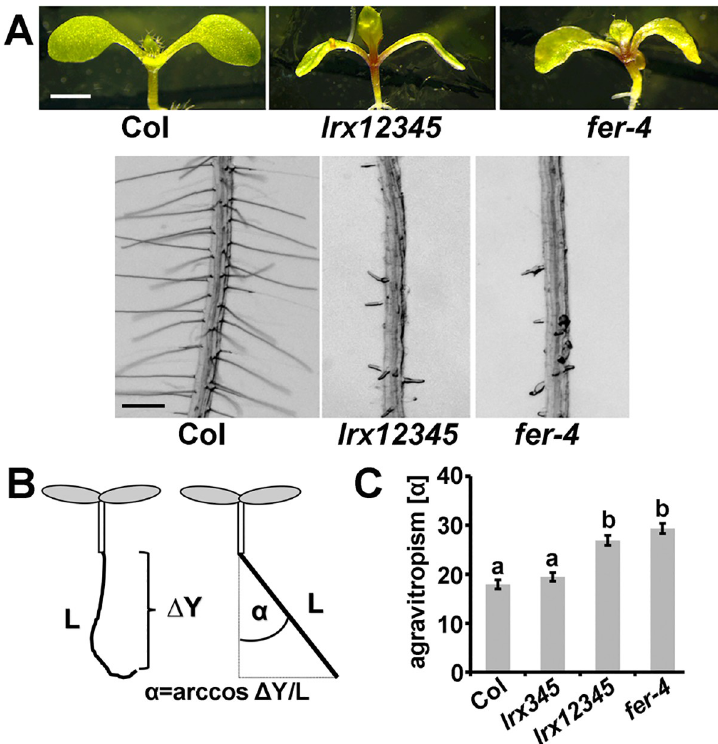
Fig 3. fer-4 and lrx12345 mutants show comparable phenotypes. (A) Seedlings were grown for 5 days on half- strength MS for analysis of root hair formation (bottom) and another 5 days for analysis of shoot development (top). (B) Quantification of gravitropic response by the root growth index. (C) Increasing agravitropy by accumulation of lrx mutations, represented by the angle α as shown in (B). Error bars represent SEM. Different letters above bars indicate significant differences (T-test, n > 20, P < 0.0001). Bar = 3 mm (A top); 0.5 mm (A bottom)